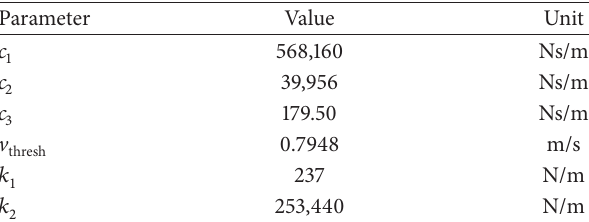
Table 3: Parameter values.